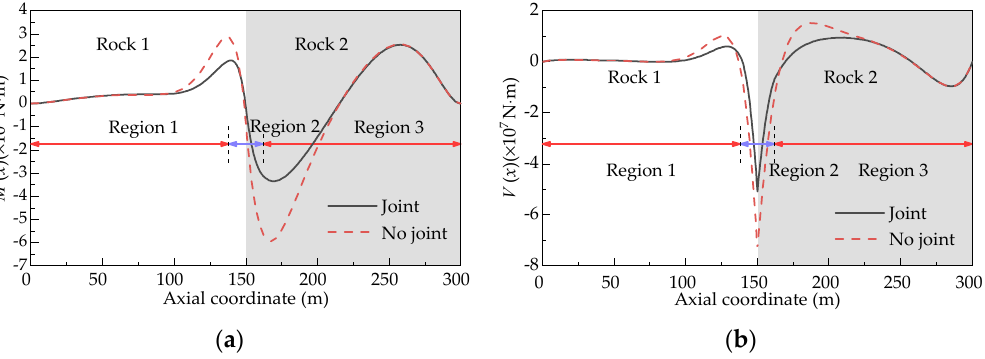
Figure 7. Influence of the joint on tunnel responses. ( a ) Bending moment; ( b ) shear force.